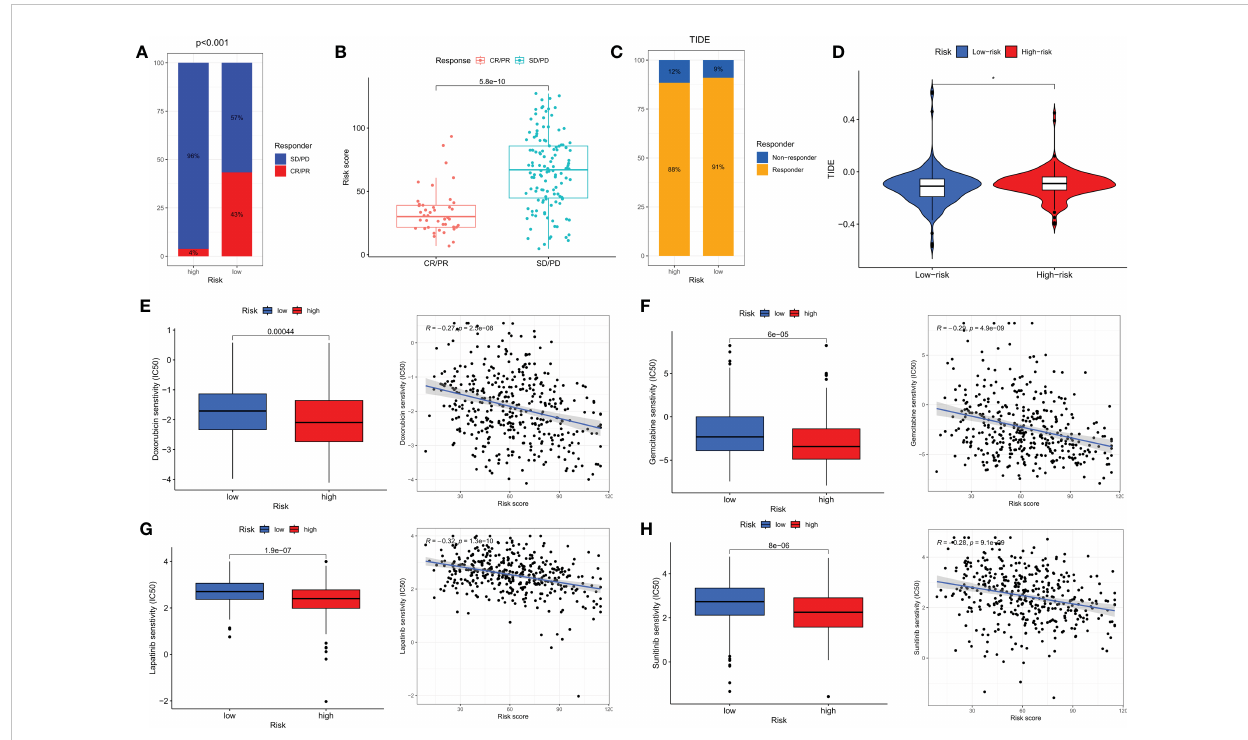
FIGURE 9 Immunotherapy and chemotherapy in different risk groups. (A) Proportions of response to anti-PD-L1 immunotherapy in high- and low-risk groups. (B) Differences in risk scores between different response groups in the IMvigor210 cohort. (C) Proportions of response to immunotherapy in high- and low-risk groups based on TIDE results. (D) Differences in TIDE scores between high- and low-risk groups. (E – H) Differences in chemotherapy sensitivity of Doxorubicin, Gemcitabine, Lapatinib, and Sunitinib among different risk groups. CR, complete response; PR, partial response; SD, stable disease; PD, progressive disease.